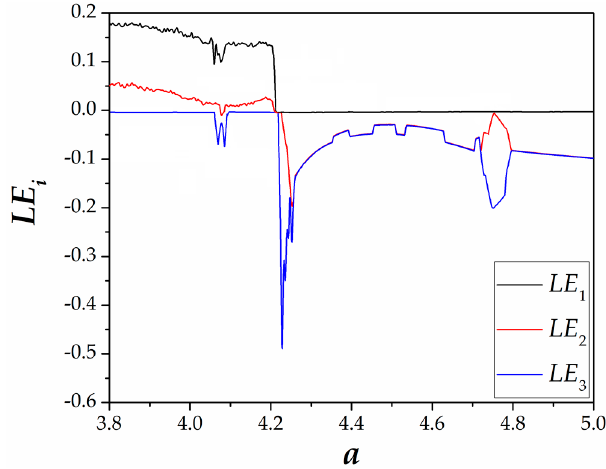
Figure 4. Spectrum of three largest Lyapunov exponents of system (8) versus the parameter a , for b = 0.1 and c = 1.5.